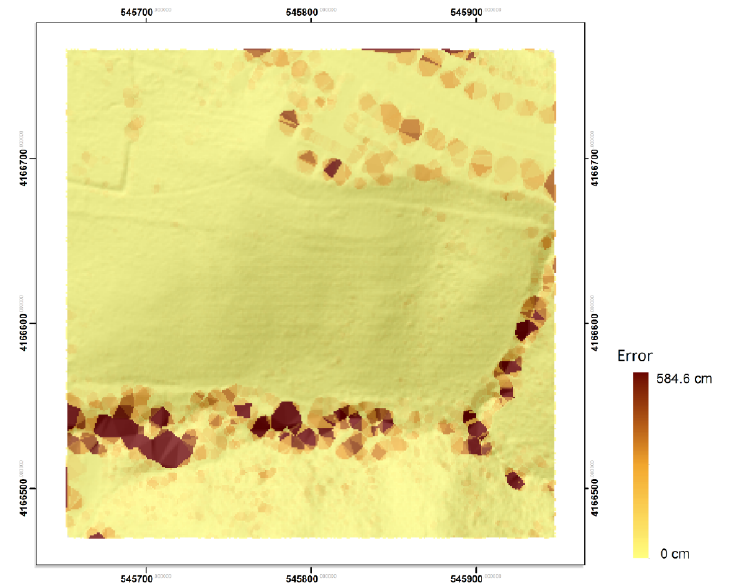
Figure 6. The spatial variation of interpolation